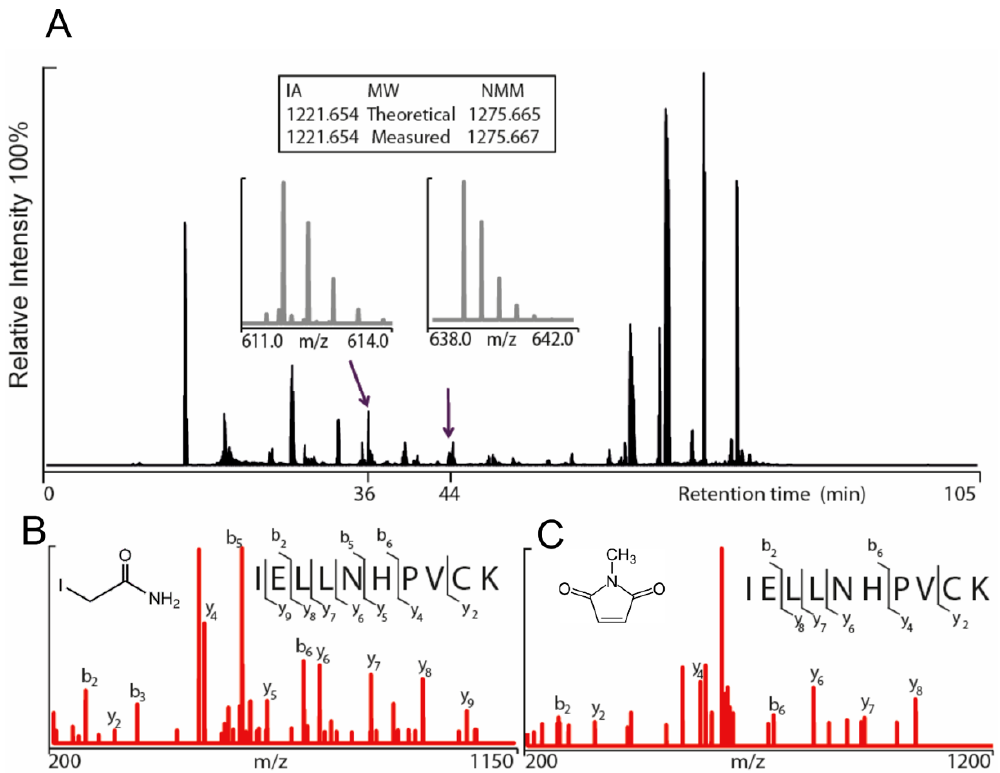
Figure 3. Annotation of iodoacetamide (IA) modified and N-methylmaleimide (NMM) modified 695–704 peptides (IELLNHPVCK) of human TRPA1 (hTRPA1) lacking the N-terminal ARD ( ∆ 1-688 hTRPA1) using nanoHPLC and tandem mass spectrometry. ( A ) Representative total ion chromatogram of trypsin digested Δ 1-688 hTRPA1 depicted in black. The IA and NMM modified peptides (695–704) for Cys703 were eluted at 36 min and 44 min respectively. The Orbitrap mass spectra of the double-charged Cys703-IA peptide ( m/z 611.8342) and the double-charged Cys703-NMM peptide ( m / z 638.8406) enabled accurate mass determination of both peptides (isotopic distribution depicted in grey). The assigned fragmentation pattern of IA ( B ) and NMM ( C ) modified peptides are given in red with indicated y- and b-ions.